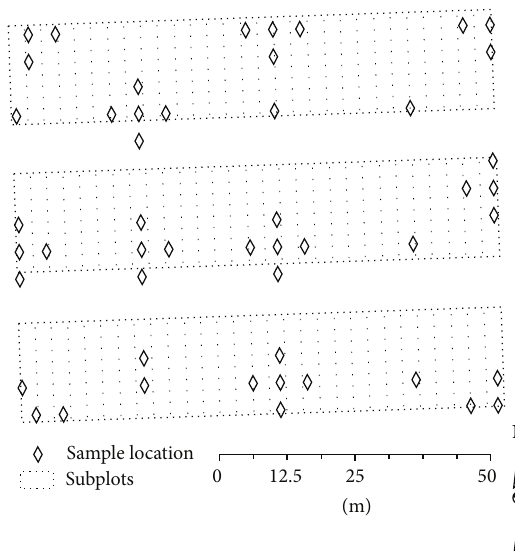
Figure 1: Soil organic matter and weed seed bank samples were taken from sample locations (diamonds). Rectangles represent potential experimental subplots, Puyallup, WA